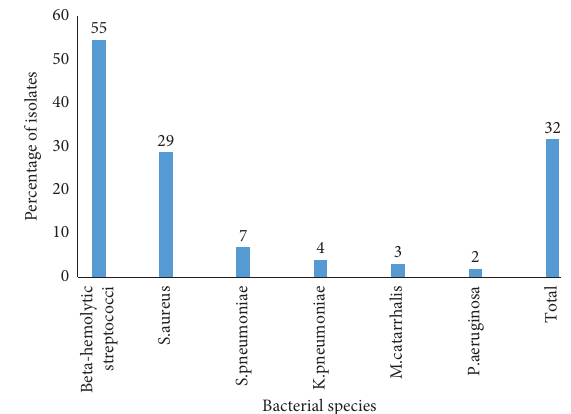
Figure 1: Frequency of bacterial species isolated from children 2 to 5 years of age with suspicion of bacterial tonsillitis at Hargeisa Group of Hospital. Table 4: Distribution of mixed isolates and MRSA from the